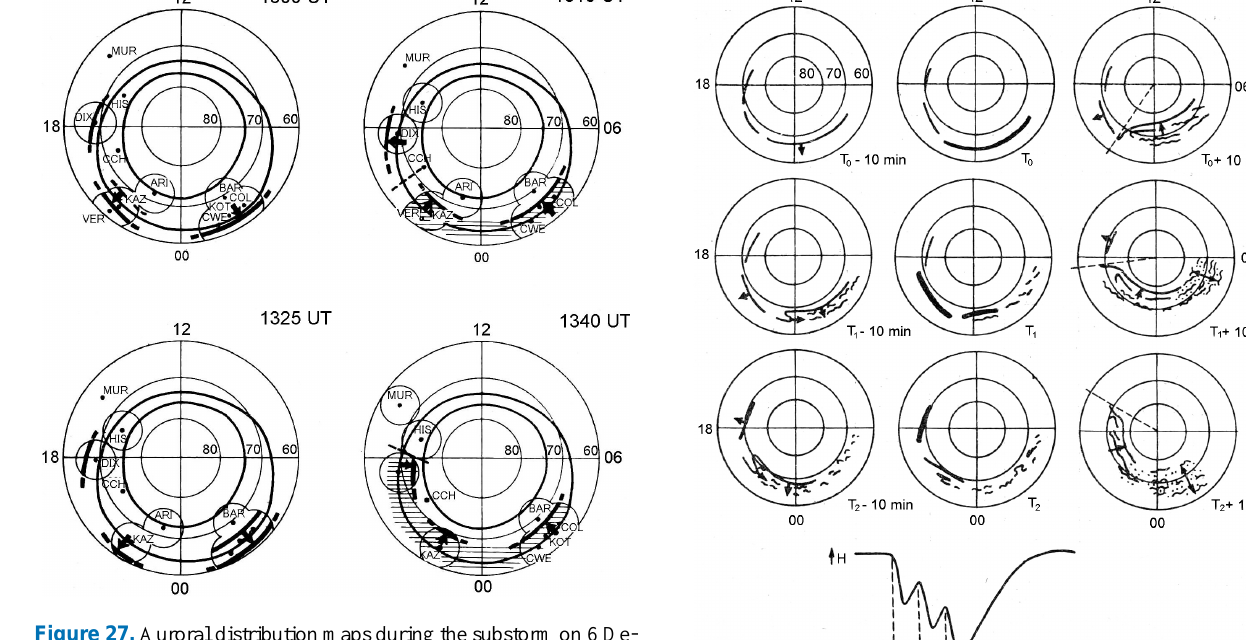
Figure 27. Auroral distribution maps during the substorm on 6 De- cember 1958. Boundaries of the Q = 4 statistical auroral oval are shown by solid lines (Vorobjev and Rezhenov, 1975).